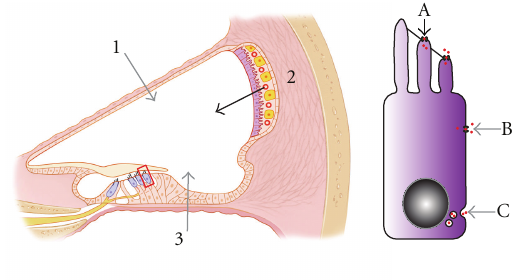
Figure 1: Proposed mechanisms of aminoglycoside transport in the inner ear. Possible entry sites for aminoglycosides into the scala media include via (1) the Reissner’s membrane, (2) stria vascularis, and (3) basilar membrane. Published work supports the notion of entry via the Reissner’s membrane and the stria vascularis through and between the marginal cells. At the hair cell level, aminoglycosides can potentially enter via mechanotransducer channels located on stereocilia of hair cells (A), endocytosis on the apical or basolateral membranes (A, B, or C), TRP channels (A, B or C), or ATP receptors